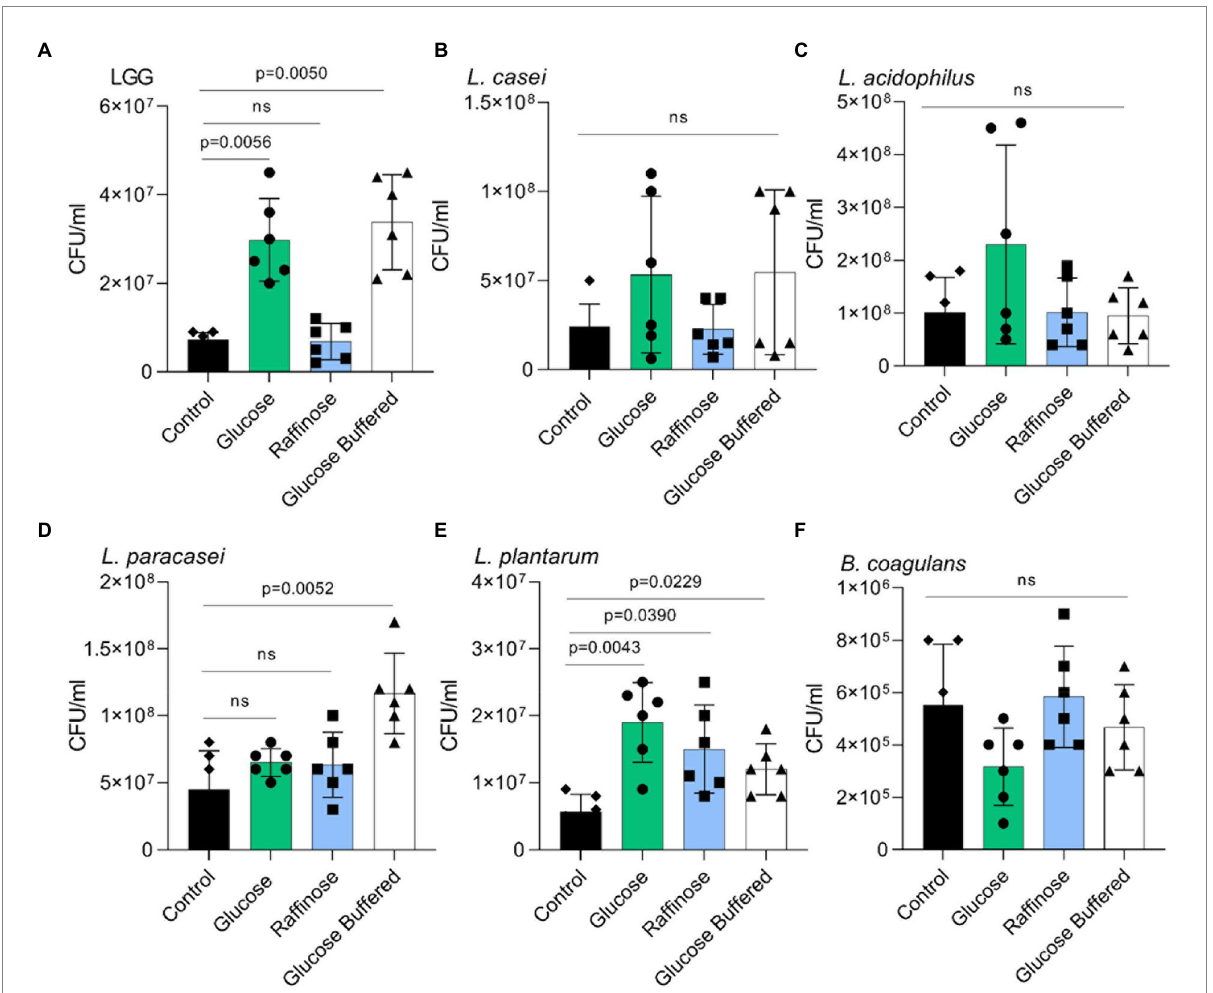
FIGURE 6 Glucose but not acid stress promotes adhesion to mucin. Adherence of the indicated species to porcine mucin in a microtiter plate. (A) LGG . (B) L. casei . (C) L. acidophilus (D) L. paracasei . (E) L. plantarum (F) B. coagulans Y-axis represents the number of bacteria adherent to mucin by CFU/ ml, graphs represent mean ± SD from 2 independent experiments (n = 6). Statistical analysis was performed using Brown-Forsythe and Welch’s ANOVA with Dunnett’s T3 multiple comparisons test. p < 0.05 was considered statistically